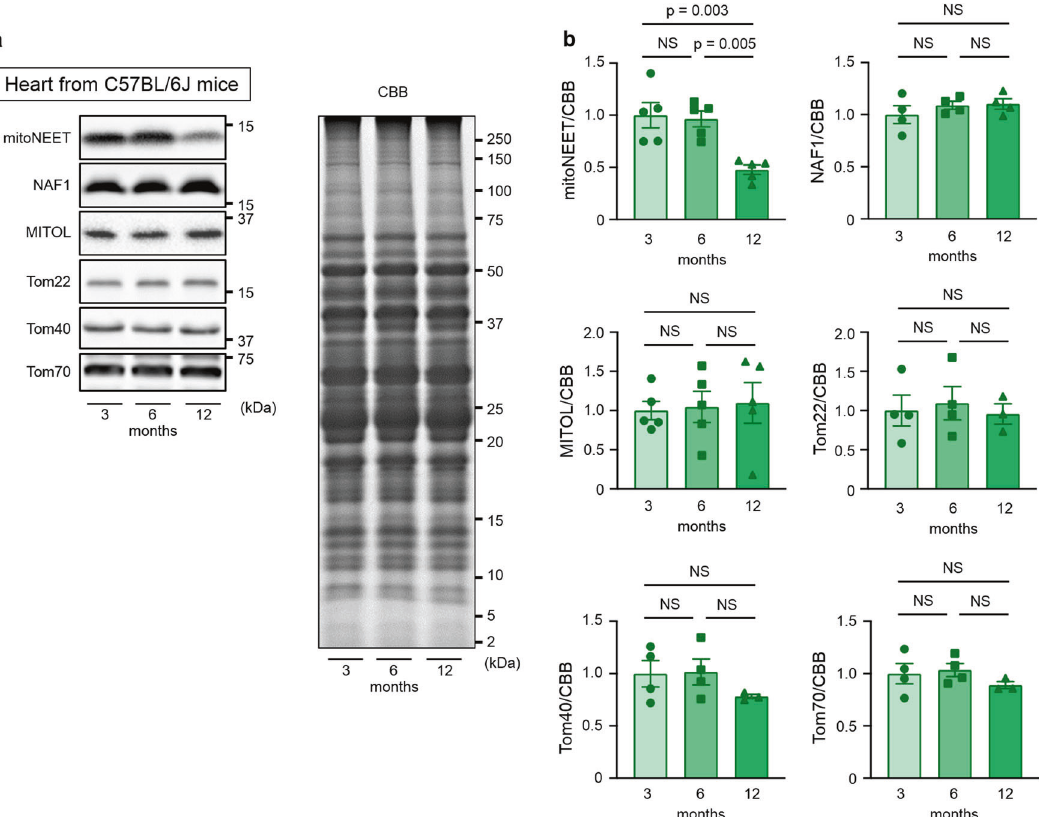
Fig. 1 MitoNEET expression is speci fi cally downregulated in the hearts of aged mice. Representative immunoblot ( a ) and summary data ( b ) of mitoNEET, Miner1, MITOL, Tom22, Tom40, and Tom70 protein expression normalized to total protein evaluated by CBB staining in the hearts of C57BL/6J mice at 3 months ( n = 5 for mitoNEET and MITOL, n = 4 or 3 for others), 6 months ( n = 5 for mitoNEET and MITOL, n = 4 or 3 for others), and 12 months ( n = 5 for mitoNEET and MITOL, n = 4 or 3 for others) of age. Data are shown as the mean ± s.e.; individual data points are shown. ANOVA was performed followed by the Tukey test for comparisons of means among 3 groups. CBB, Coomassie Brilliant Blue; NS, not signi fi